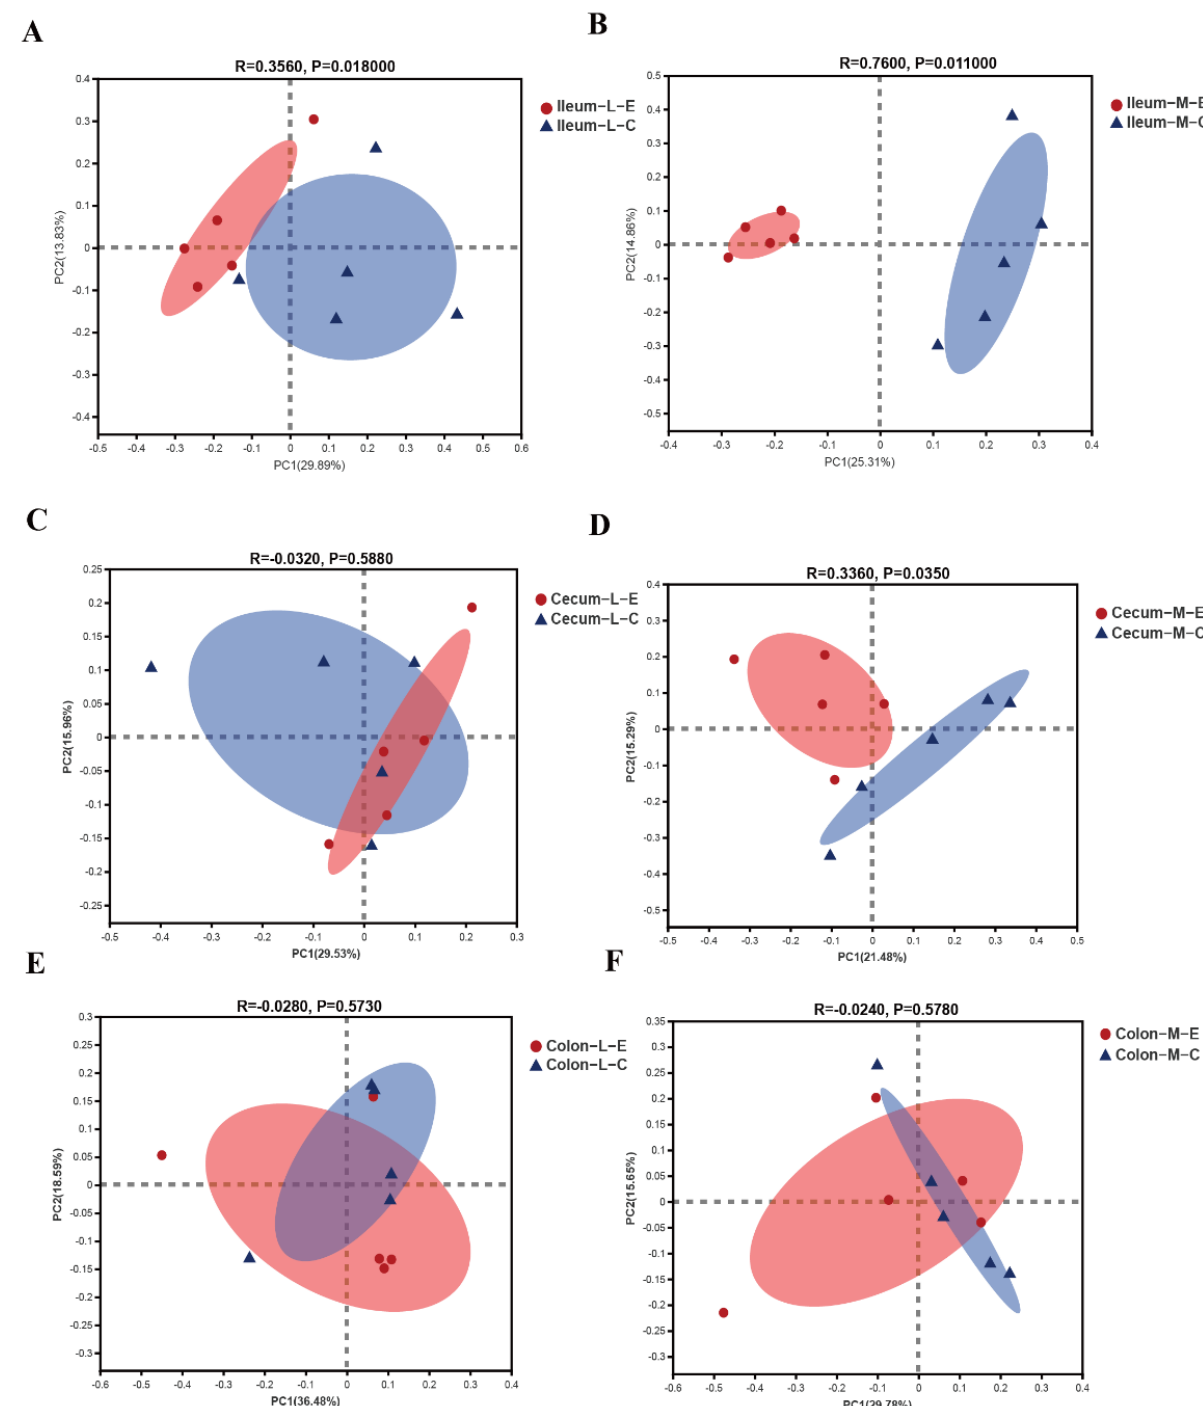
Figure 3. Unweighted principal coordinates (PCoA) of microbiota in different inches. ( A ) Ileal luminal contents. ( B ) Ileal mucosa. ( C ) Cecal luminal contents. ( D ) Cecal mucosa. ( E ) Colonic luminal contents. ( F ) Colonic mucosa. M, mucosa; C, control; E, Enterococcus faecium HDRsEf1. Table 1. ANOSIM R-values of microbial community between HDRsEf1 group and the control group.